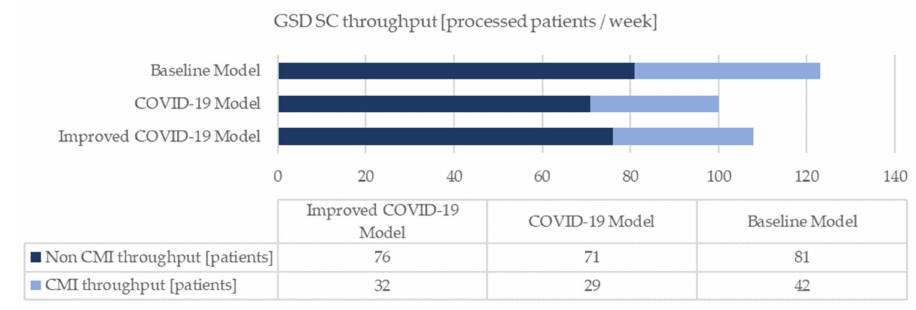
Figure 6. GSD SC throughput.